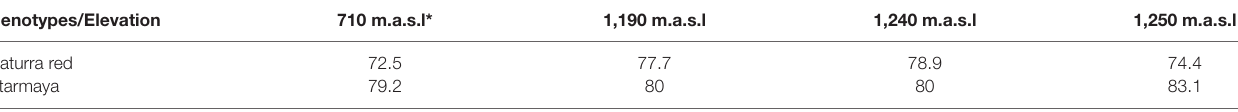
TABLE 3 | Score of sensorial perception according to the Specialty Coffee Association method and made by Illy Caffè (Italy).